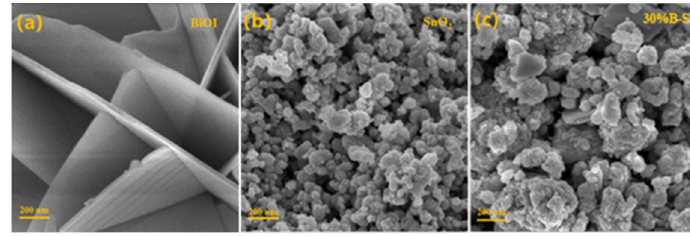
Figure 5. SEM images of ( a ) BiOI, ( b ) SnO 2 , and ( c ) 30%B-S.